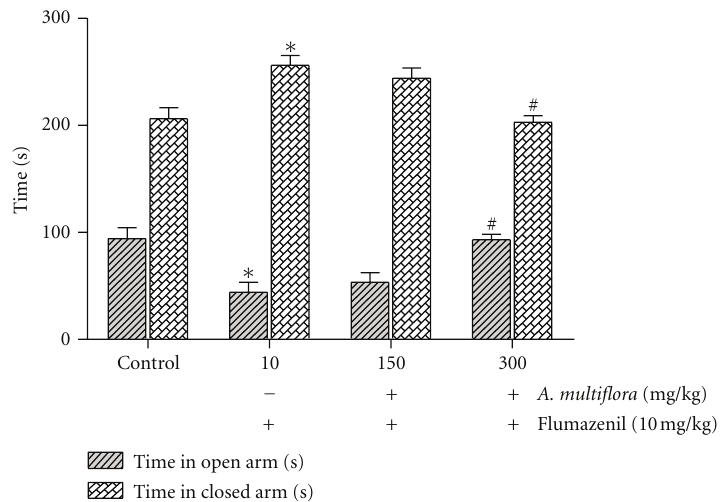
Figure 3: Antagonistic e ff ect of flumazenil on the anxiolytic-like e ff ect of the aqueous extract of A. multiflora stem bark in rats. Flumazenil (10mg/kg) or vehicle was administered intraperitoneally. The data is expressed as the mean ± SEM of the percentage of the time spent and the number of entries into the open arms of the elevated plus maze over 5min test period. ∗ P < 0 . 05 compared to the vehicle-treated control group; # P < 0 . 05 versus the flumazenil treated group, n = 6 rats per group.